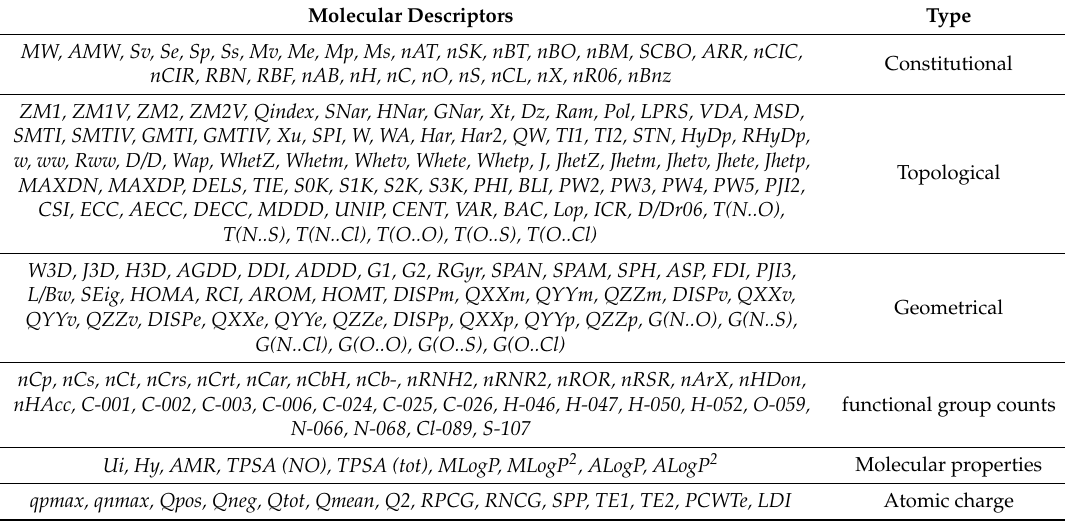
Table 8. Molecular descriptors obtained from DRAGON